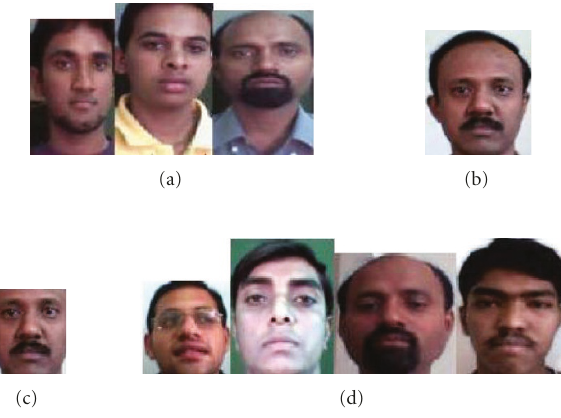
Figure 1: (a) Face segmented using skin colour regions (b) full face (c) closely cropped face (d) faces of various